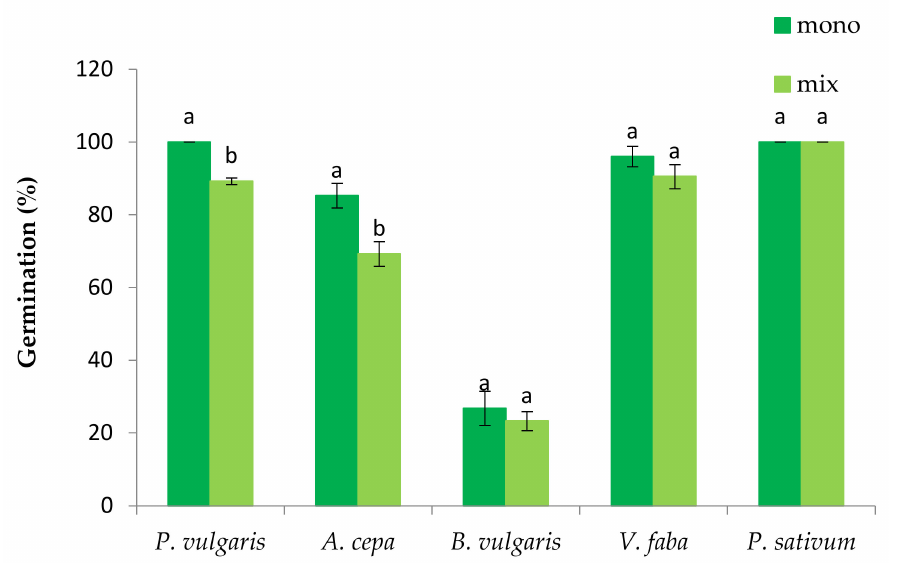
Figure 1. Germination percent of crop species grown together with P. oleracea seeds (mono = only crop plant; mix = crop grown together with P. oleracea ). Bars represent the means of 4 replicates ± SE. Bars topped by the same letter indicate no significant difference between treatments at the 5% level using Duncan’s multiple-range